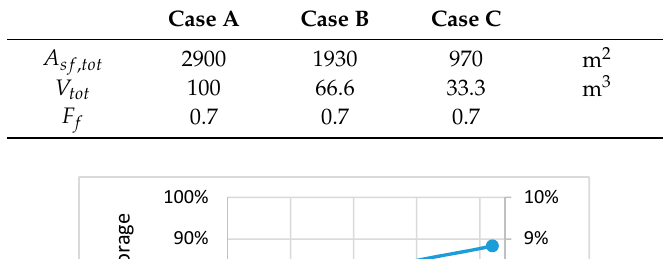
Table 2. Geometrical parameters of simulated cases.